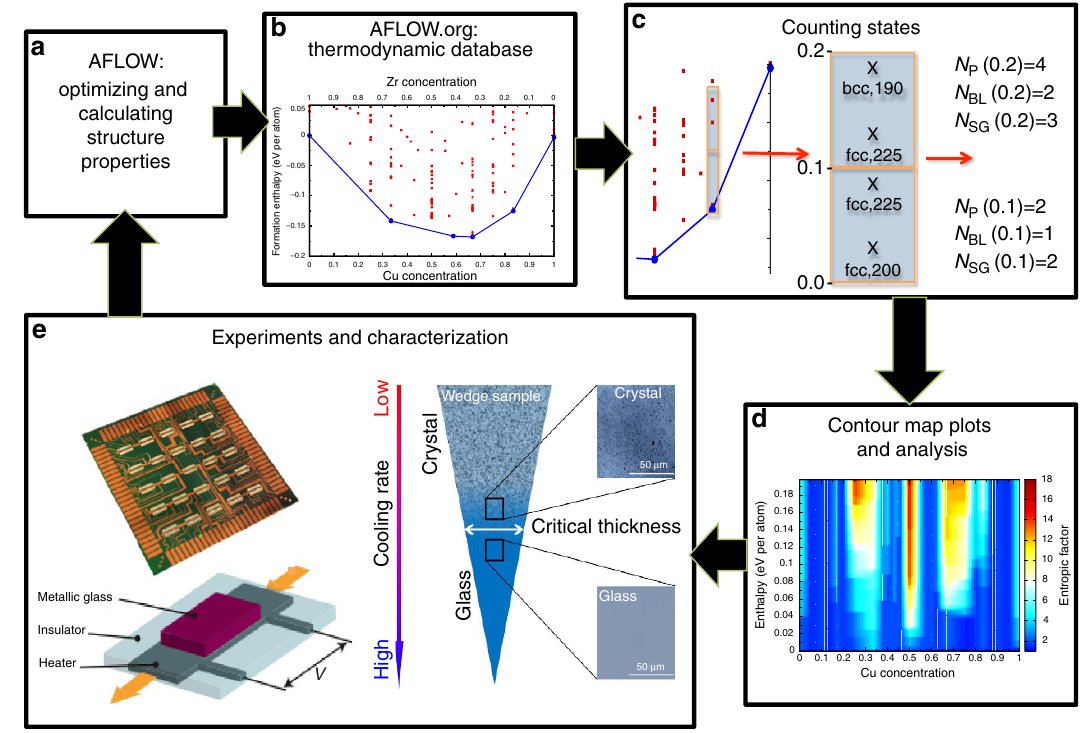
Figure 2 | Integration of experimental and computational approaches. ( a ) Multiple different structures for a given stoichiometry are built using the AFLOW prototype libraries 30 , which are then optimized via VASP calculations under the AFLOW standard settings 53 . ( b ) The resulting data are added to the open thermodynamic database AFLOW 48,49 . ( c ) These data are accessed and used to obtain statistics on the cumulative distribution of entries ( N P ), Bravais lattices types ( N BL ) and space groups ( N SG ) within a given formation enthalpy range (starting at zero). ( d ) Contour map plots are created from these distributions, allowing the identification of the best glass-forming alloys. ( e ) Finally, experimental synthesis and characterization are used to verify the computational